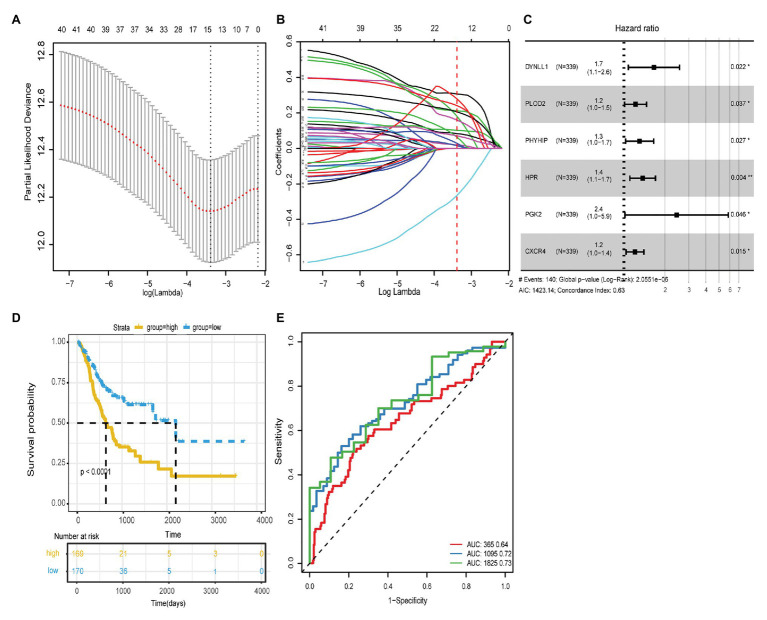
(A) The regression analysis of 1,000 times was carried out with Lasso regression, and the single factor appeared more than 500 times was screened. Finally, 15 autophagy genes were obtained. (B) Lasso filters variables. (C) Forest plot of HR of six genes. (D) The ROC curves of risk score model for the prognostic accuracy of GC patients in 1, 3, and 5-year; AUC is the area under the curve, and the larger the value, the better the model. (E) Kaplan-Meier survival curve analysis of risk score model.